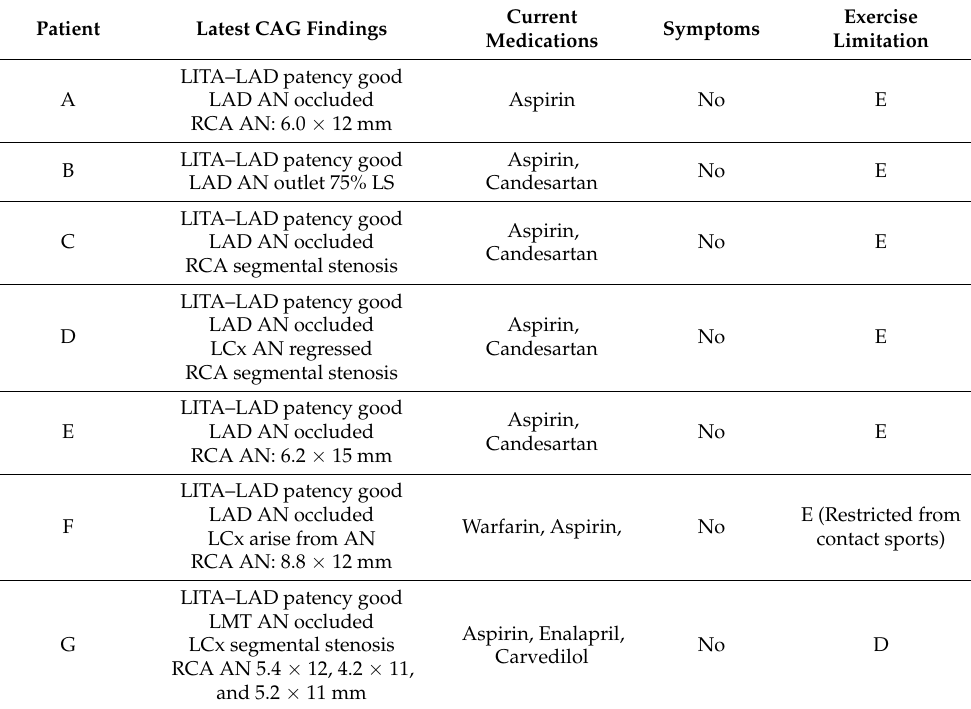
Table 3. The latest CAG findings; Current medications and symptoms; Exercise limitation.